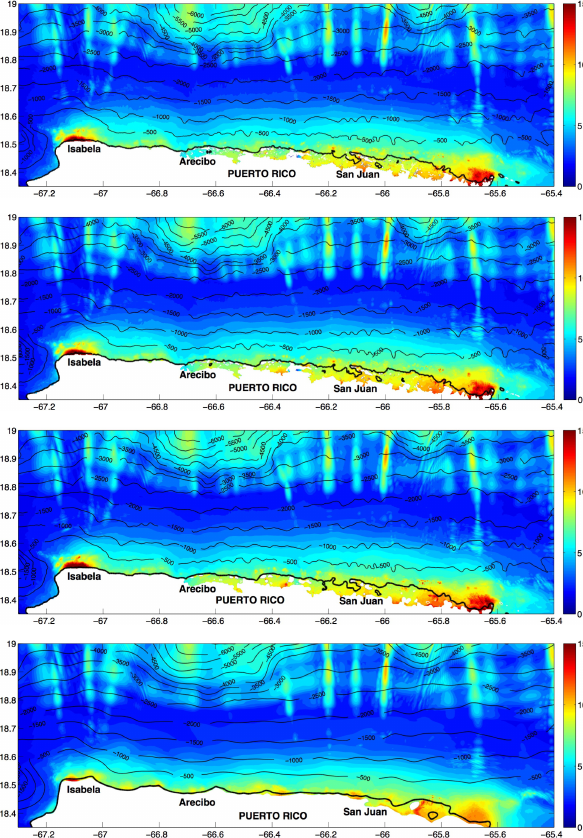
Fig. 9. Bathymetry (black isobaths marked in meters) and maxi- mum tsunami surface elevation (color scale in meters), for the same source as in Figs. 6 and 7, using a 3 00 model grid with downgraded bathymetry obtained by re-interpolating the 3s. data of Fig. 5 by krigging, on 6 00 , 12 00 , 24 00 , and 48 00 grids (top to bottom).